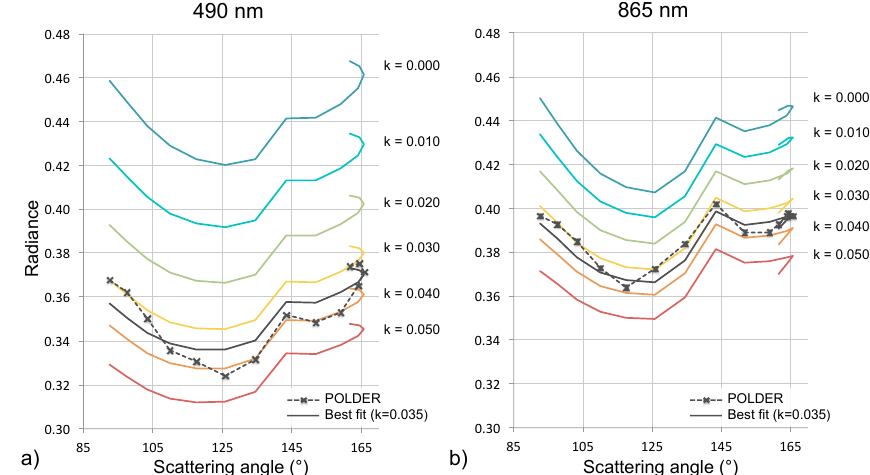
Figure 4. Example of measured and simulated total radiances for one pixel at 490nm (a) and 865nm (b) . The dashed black lines are for the measurements and the continuous black ones are for the simulated signals corresponding to the solution (i.e., COT = 12.4; k = 0.035; AOT = 0.14). Other colored lines correspond to the signal simulated for the same COT, the same scattering AOT values and for several k (i.e., different absorption AOT